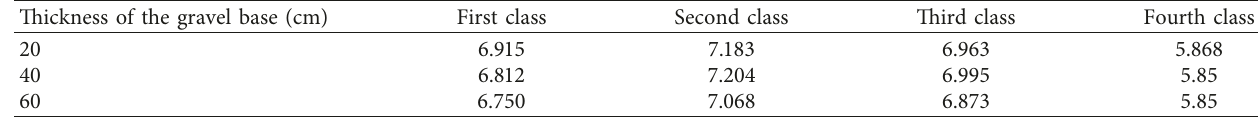
Table 3: Vertical deformation for the asphalt pavement thickness of 15cm.